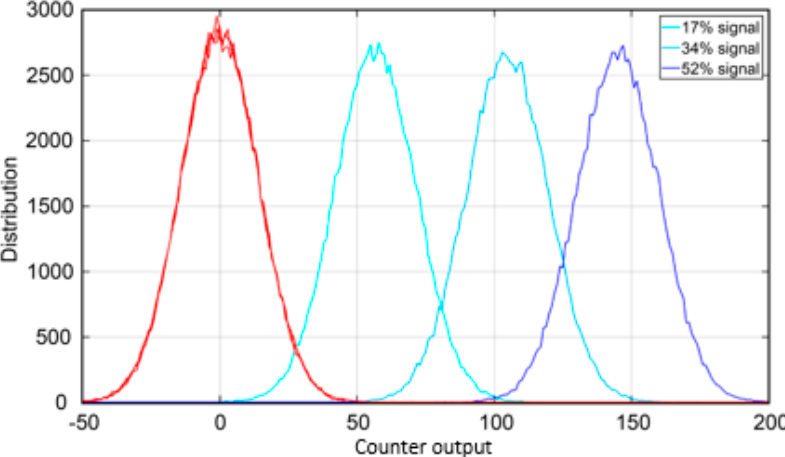
Figure 12. Up/down counter’s output after 500 laser shots, achieved with 10 6 Monte Carlo simula- tions in the worst-case conditions (lowest laser echo signal). The red curve represents SPADs not covered by the laser spot (resulting in 0 counts on average), whereas the blue and light blue curves represent SPADs covered by the laser spot, respectively with 52%, 34%, or 17% probability to detect a photon per SPAD per each laser shot.